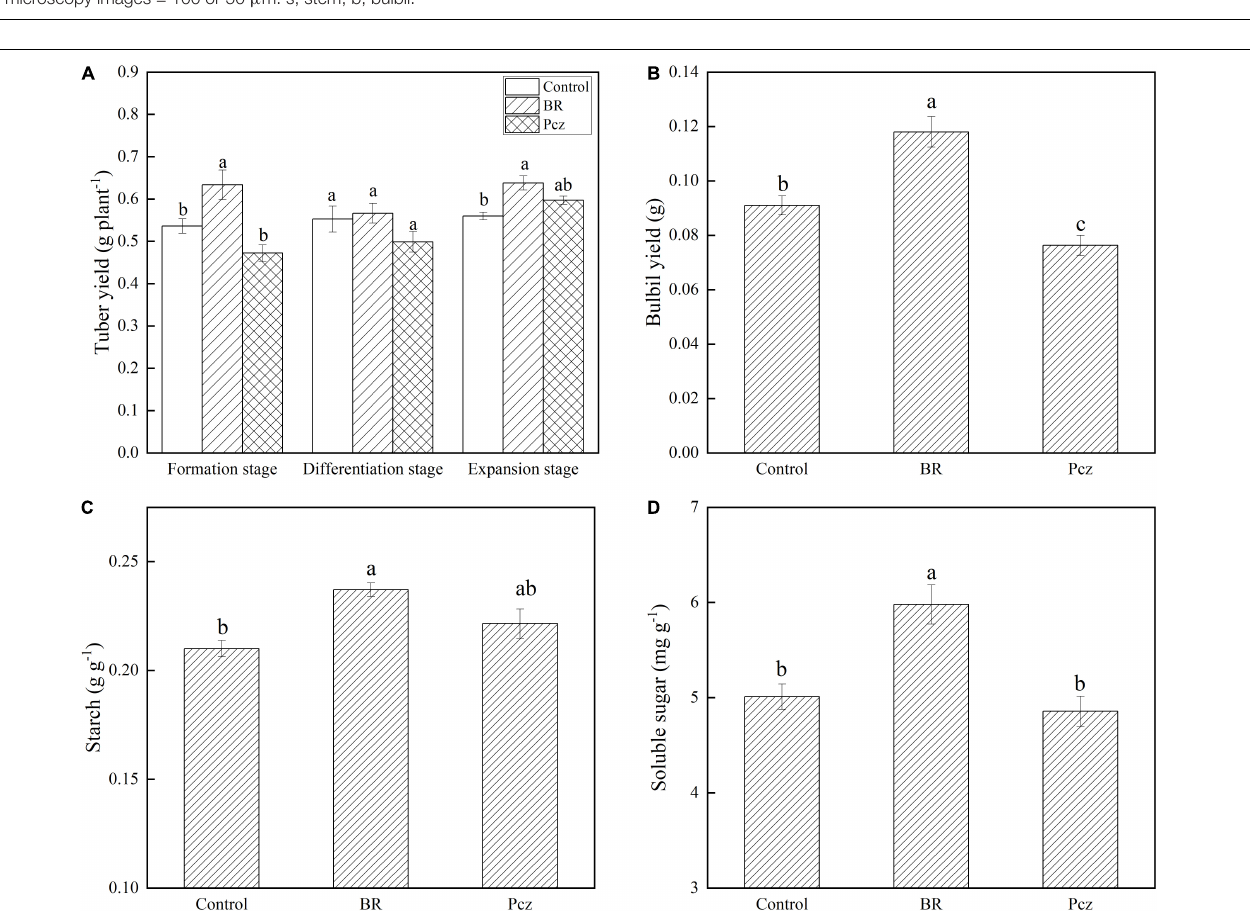
FIGURE 2 | Tuber yield (A) , bulbil yield (B) , starch (C) , and soluble sugar (D) content in bulbil of P. ternata under BR and Pcz treatments. The bars with different letters are significantly different from each treatment ( p < 0.05). Values are means of four replicates ± SE.